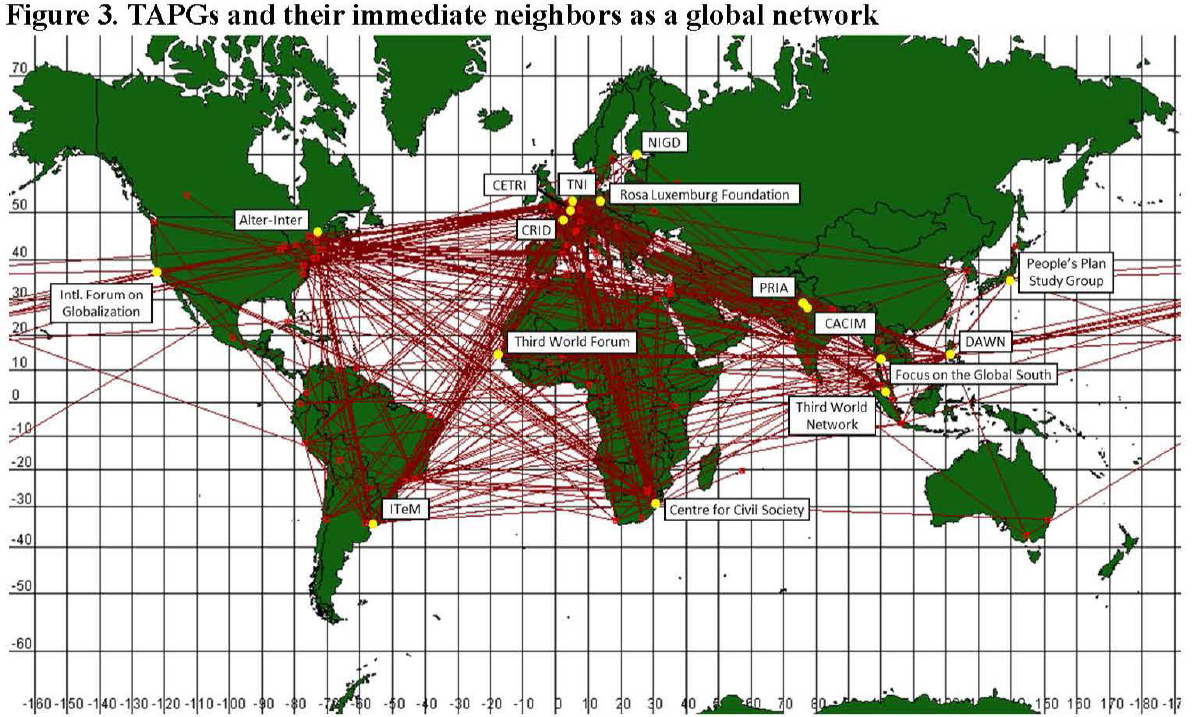
Figure 3. TAPGs and their immediate neighbors as a global network